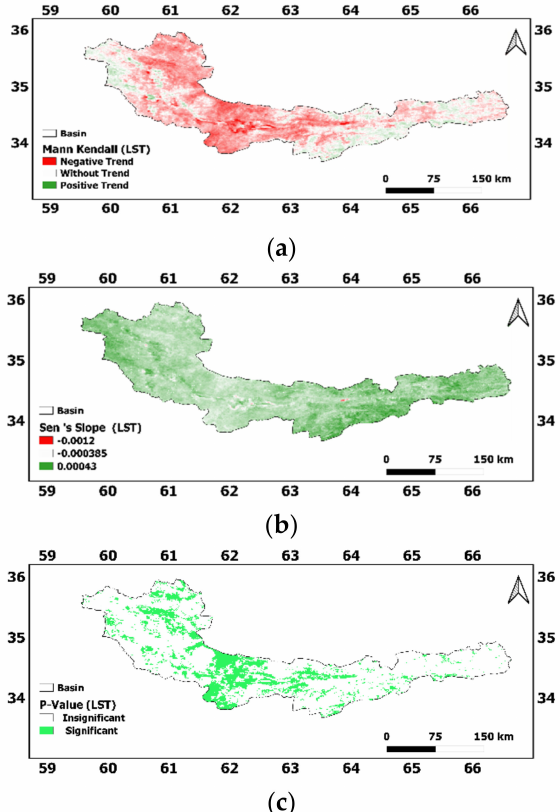
Figure 8. ( a ) Spatial distribution map of trend status of land surface temperature ( ◦ C) in the Doosti Dam’s basin based on MODIS LST dataset (MOD11) using Kendall estimator, ( b ) spatial distribution of trend intensity of LST ( ◦ C) using Sen’s Slope Estimator (Z = 1.96 at 95% confidence level), ( c ) spatial distribution of significant trends using p factor, over the 18-year period (2004–2021) in the Doosti Dam’s